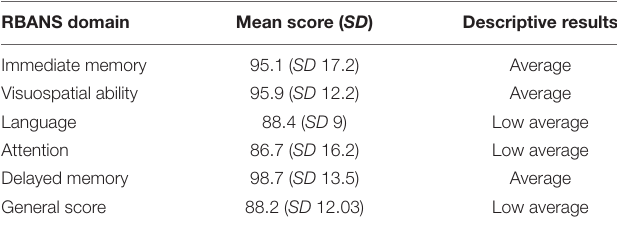
TABLE 4 | Mean and standard deviation of the RBANS scores in pre-program